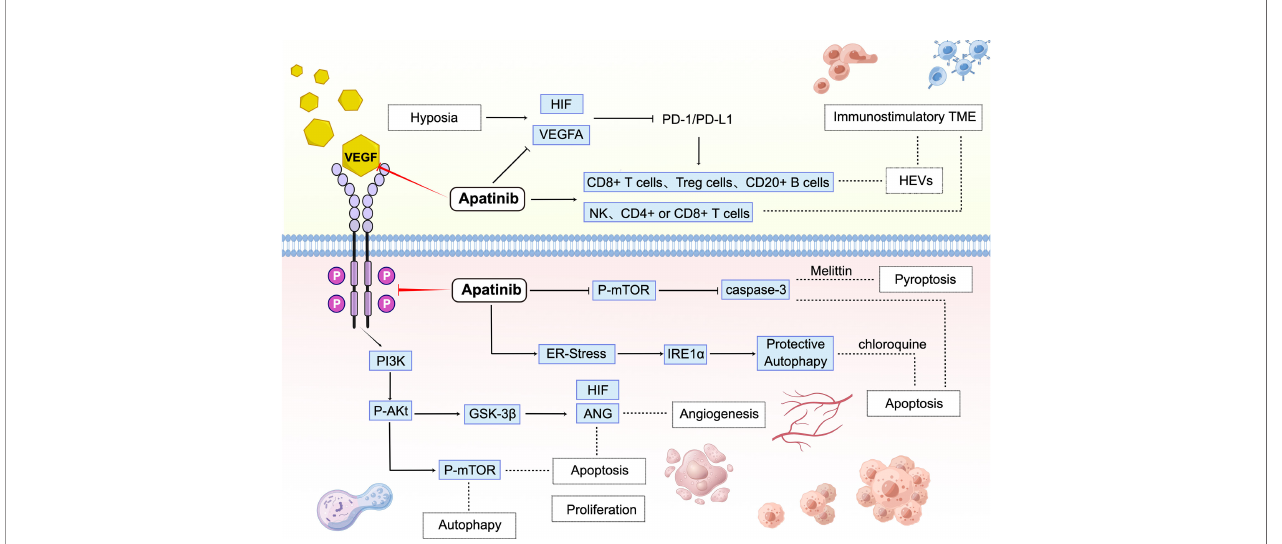
FIGURE 1 | Molecular mechanisms involved in the antitumor effect of apatinib monotherapy and combination